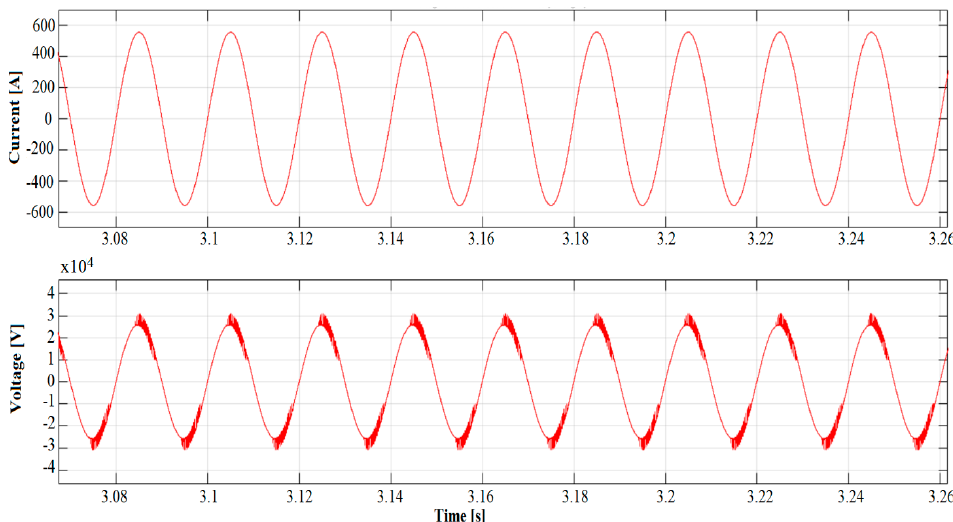
Figure 19. Voltage on the train position and current drawn by the train with two trains on the track.